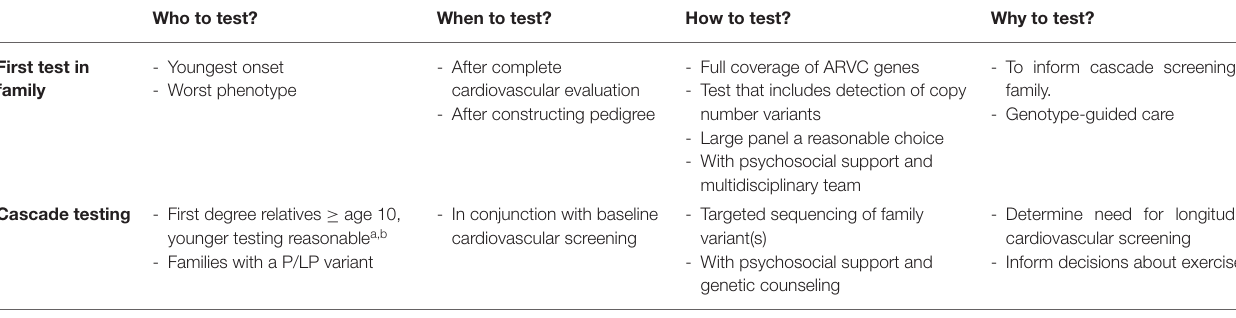
TABLE 2 | Pediatric genetic testing overview.